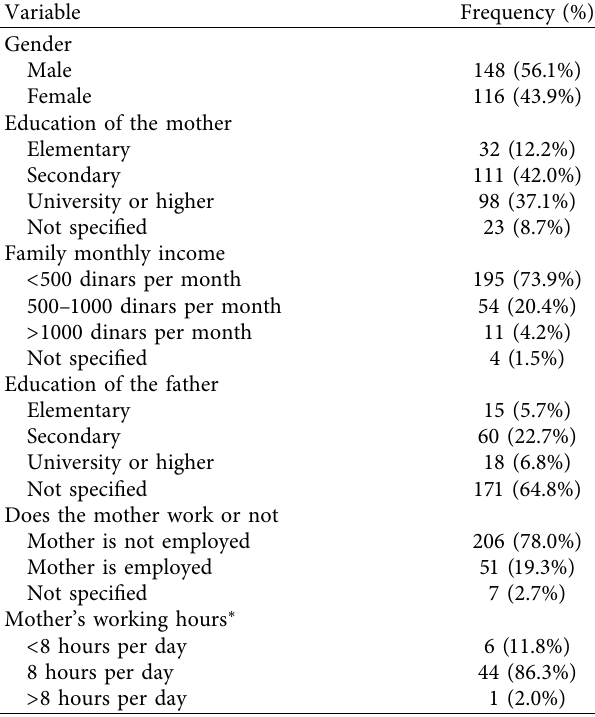
Table 1: General characteristics of the children’s families.